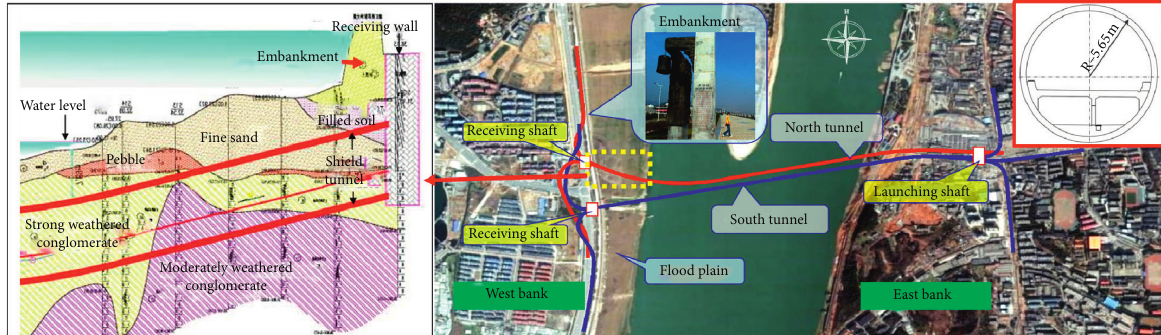
Figure 2: Overview of the cross-river shield